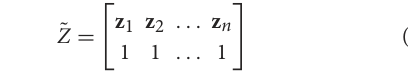
FIGURE1 The first three steps of an unfolded recurrent schematic of the RNN architecture used in this paper. There are two layers d (1) t and d (2) t in this